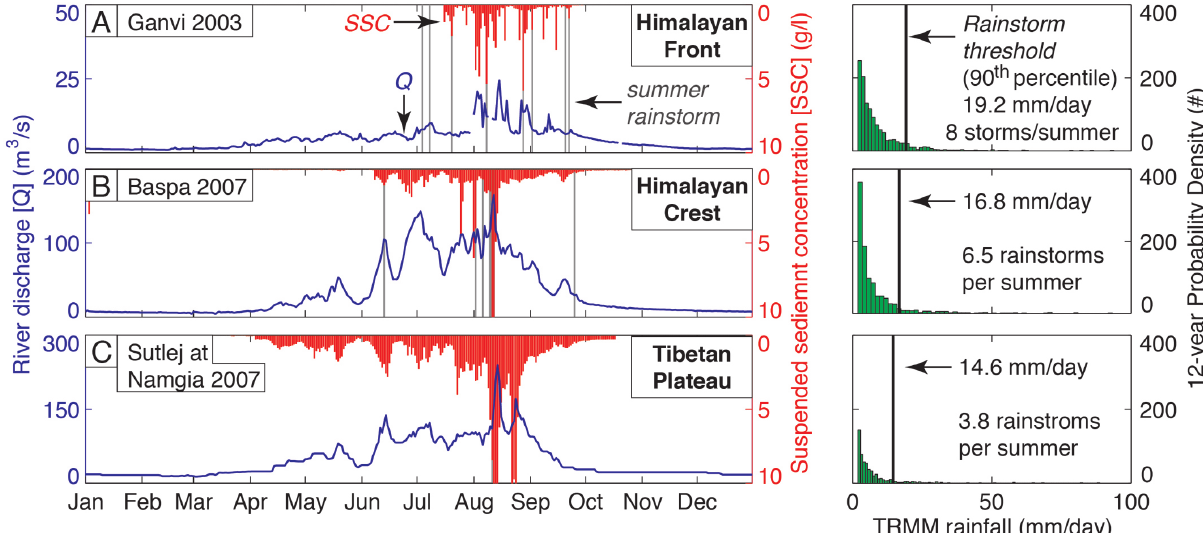
Fig. 2. Annual course of river discharge ( Q ) and suspended sediment concentration (SSC) underlain by summer rainstorms (May–October) in different orogenic regions represented by the Ganvi tributary during the year 2003 (A) , the Baspa tributary during 2007 (B) , and the Sutlej River at Namgia during 2007 (C) . Panels on the right show the catchment-respective probability density (number of occurrences) of wet rainfall days ≥ 2mm in 1mmday − 1 bins as taken from the 12-yr TRMM 3B42 data set. Note that SSC data in (A) are restricted to 77 days from mid-July to